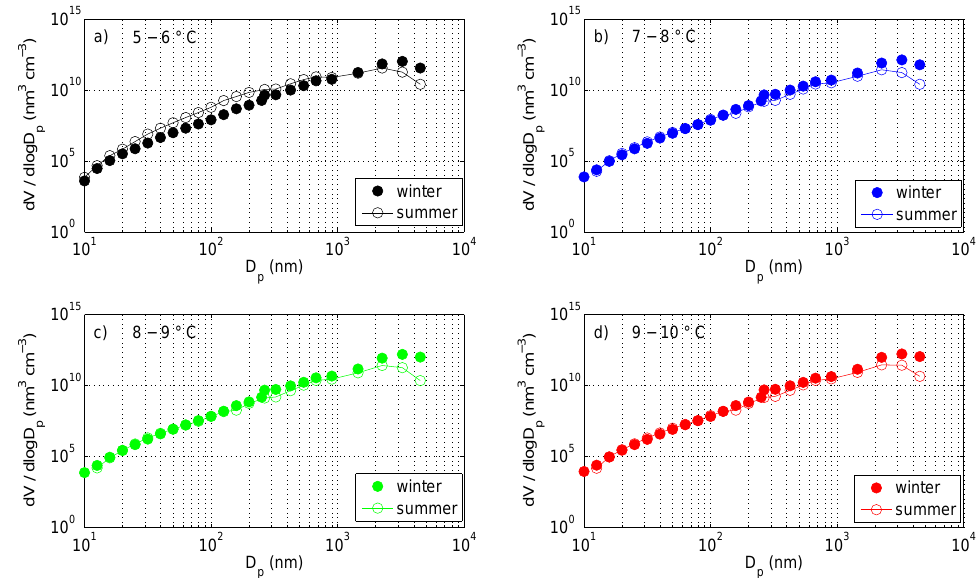
Fig. 7. Comparison of particle volume size distributions resulting from water sampled close to the glacier during summertime and wintertime, for the same water temperature ranges of (a) 5–6 ◦ C, (b) 7–8 ◦ C, (c) 8–9 ◦ C and (d) 9–10 ◦ C. For clarity only every second data point is shown.